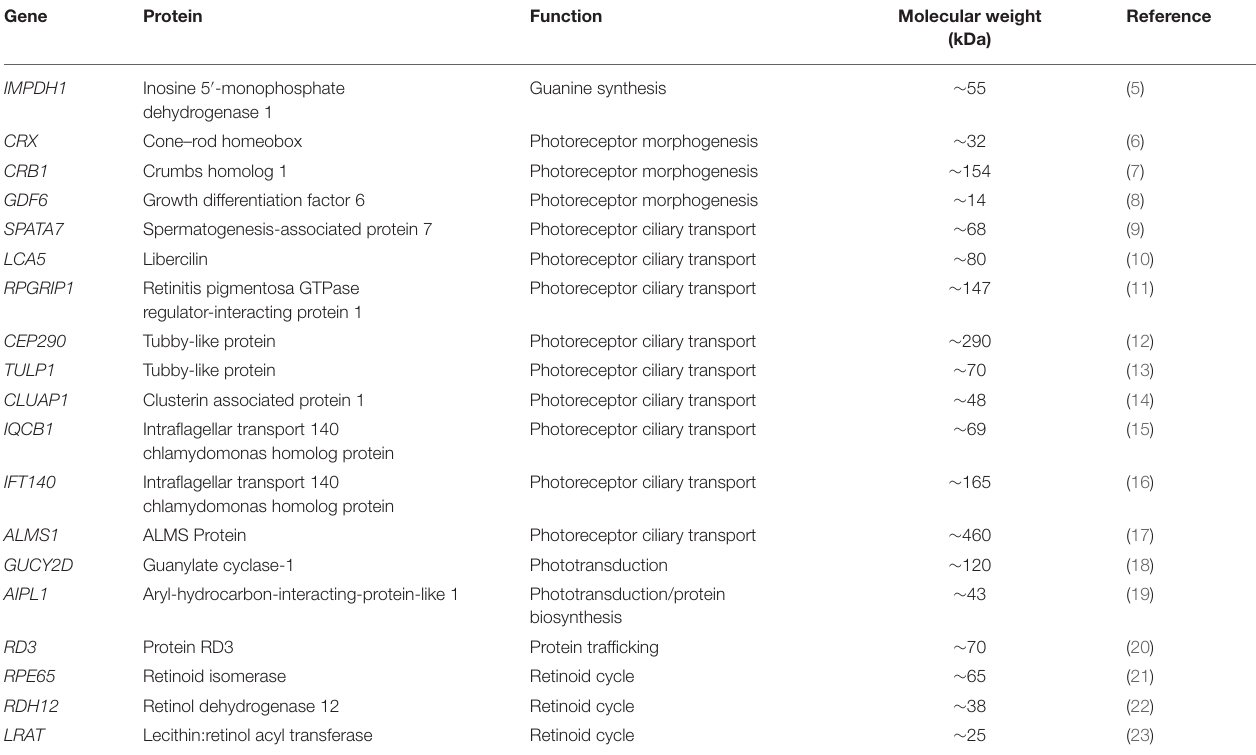
TABLE 1 | Main genes associated with the onset of LCA.